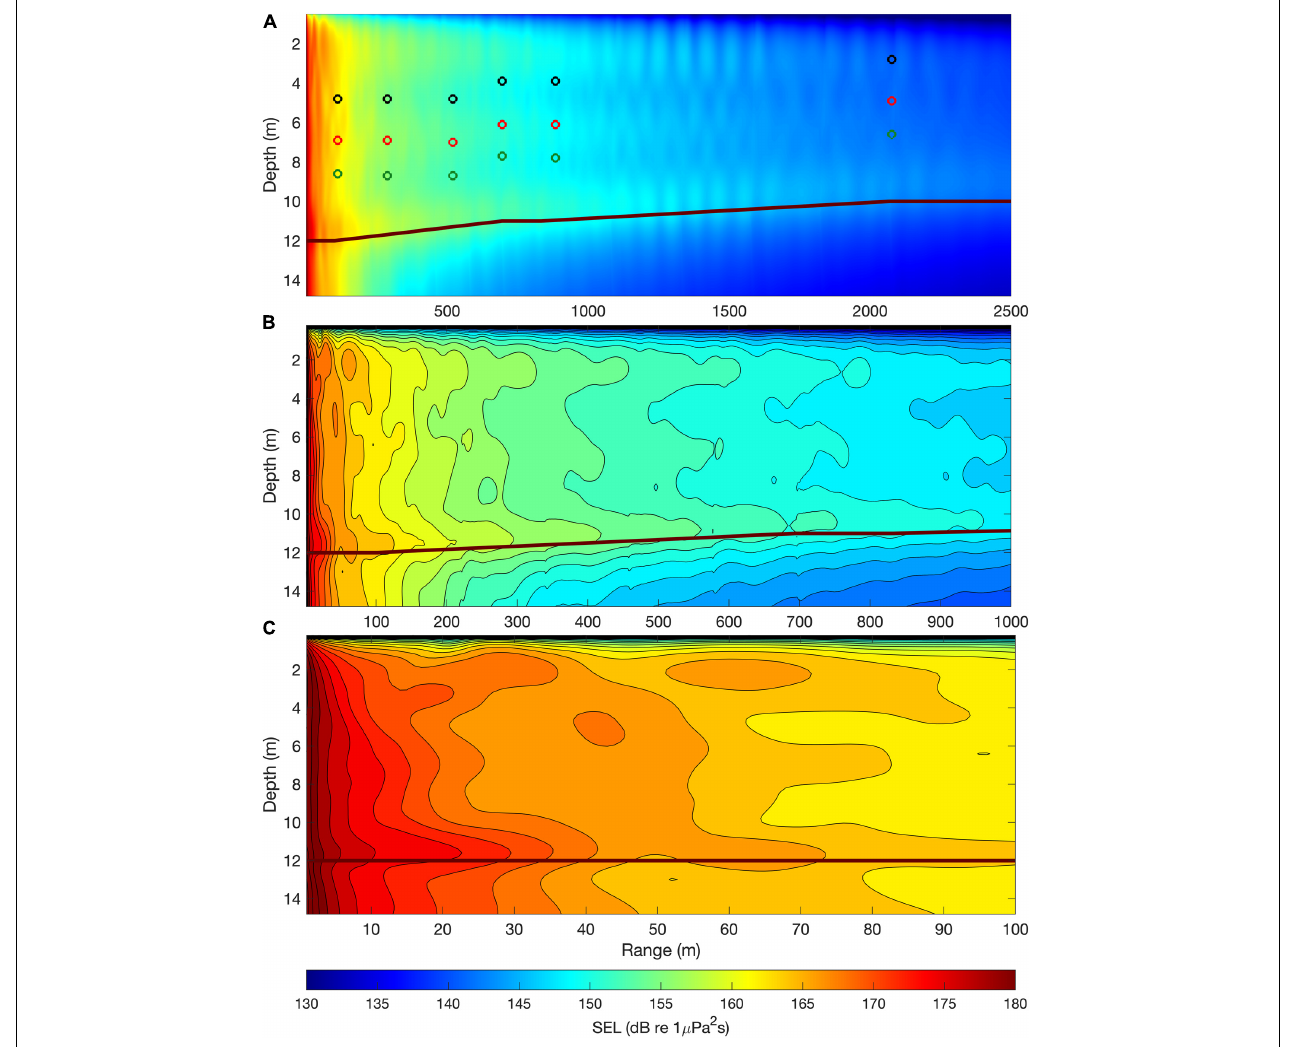
FIGURE 9 | (A) PE-simulation of acoustic field produced by the impact pile driving. Hydrophone positions were marked with circles (green, red, and black positions are 3, 5, and 7 m above the seabed). The brown line represents the water-sediment interface. Water depths gradually decreased as the distance from the pile increased. (B) Expanded view of the simulated acoustic field with contours up to the distance of 1,000 m. (C) Further expanded view up to distance of 100